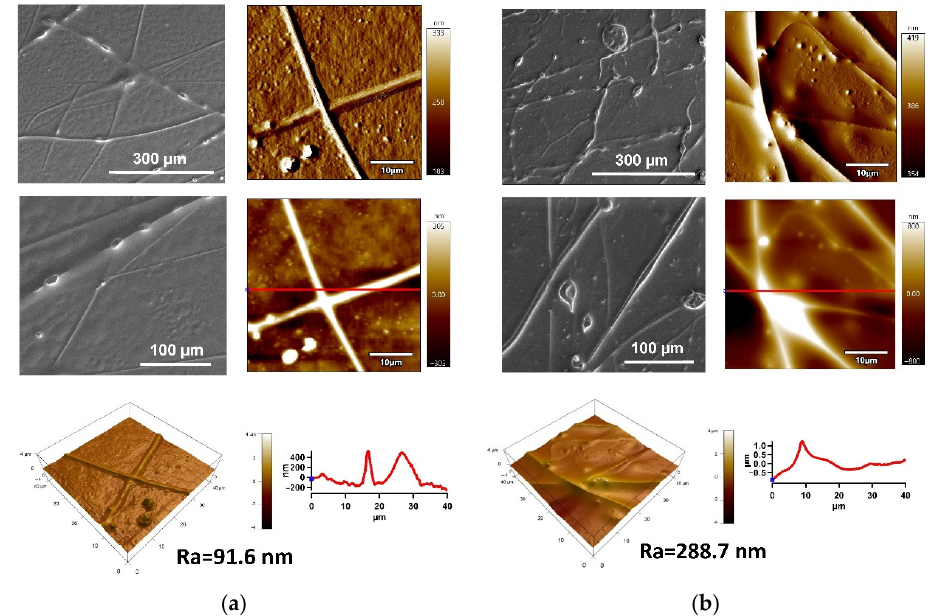
Figure 6. AFM images (from left to right: 3D height, amplitude, ZSensor with line profile) of PS/PDMS/BSO (PS/PDMS/THF—1:1:10 (g/g/mL)) on: ( a ) PE and ( b ) PU substrates. PS/PDMS/BSO (PS/PDMS/THF—1:1:10 (g/g/mL)) on: ( a ) PE and ( b ) PU